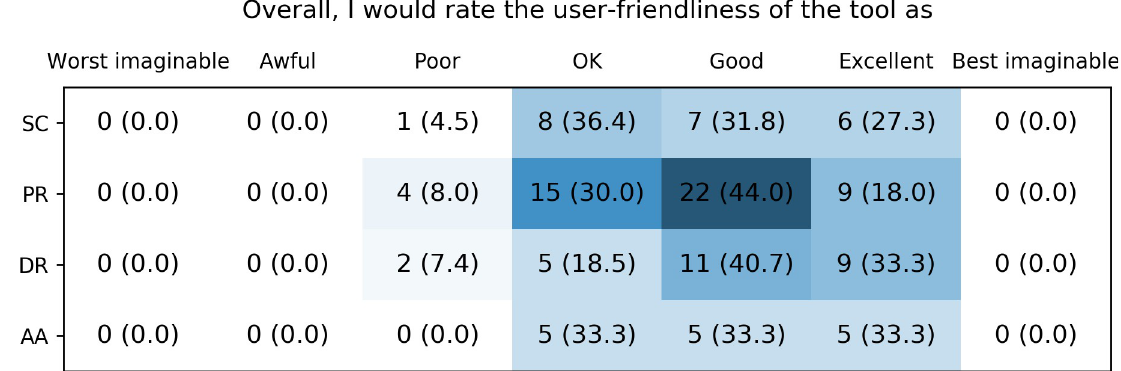
Fig 10. Healthcare providers’ rating of the user-friendliness of the different CDS tools. SC: Safety Code cards, PR: printed reports, DR: digital reports, AA: automatic alerts.